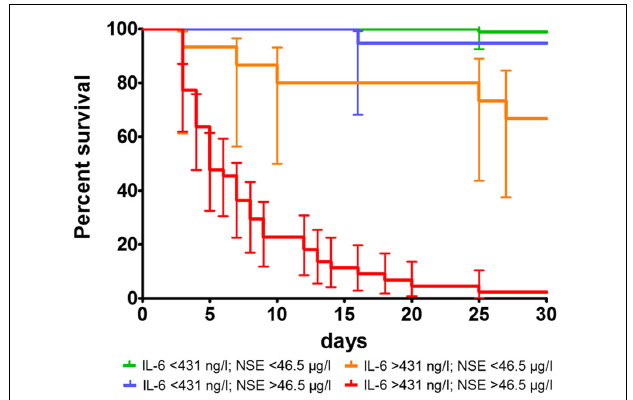
FIGURE 4 | Survival proportions of combined determined cut-off values for mortality for IL-6 and NSE. p was < 0.0001 in log-rank test.